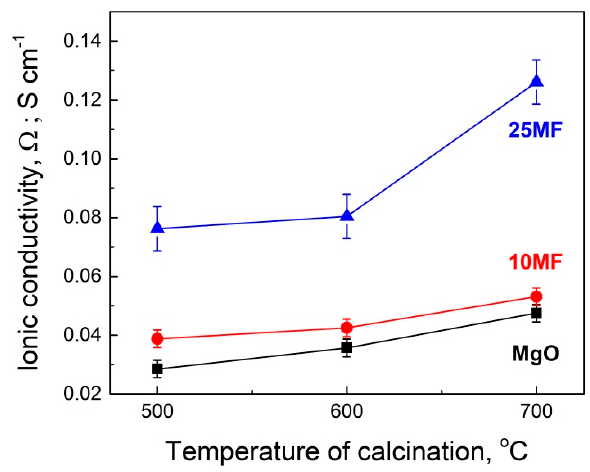
Figure 3. Changes in the ionic conductivity of pellets of the MgF 2 -MgO system, containing 10 and 25 mol.% MgF 2 as a function of the temperature.